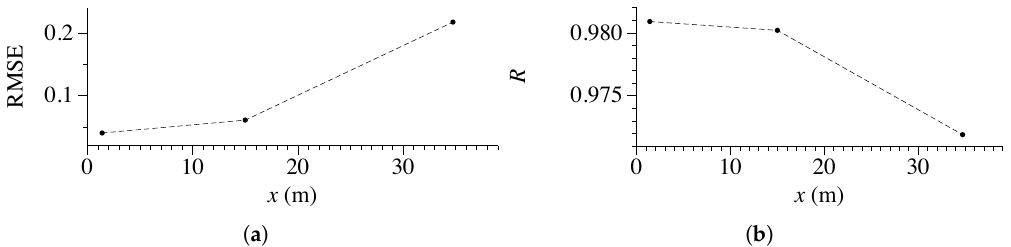
Figure 12. Comparison of accuracy between the numerical and experimental wave signal at different wave gauge positions by ( a ) RMSE for wave phases; ( b ) R